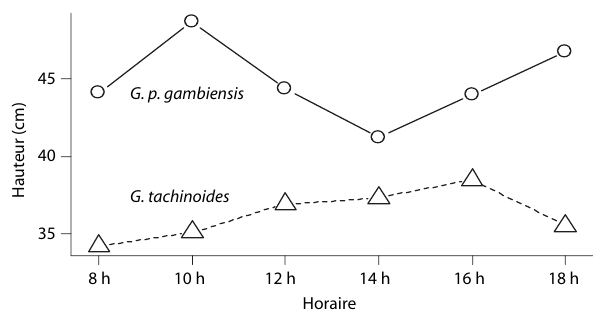
Figure 3. – Variations de la hauteur de capture G. tachinoides et G. p. gambiensis en fonction de l’horaire. La hauteur indique ici la pose de la glossine sur